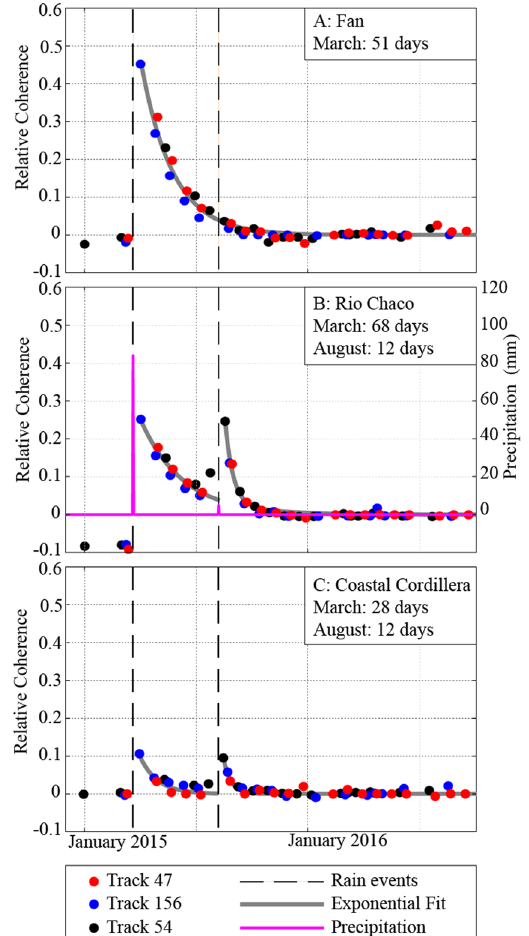
the 2 nd rain event can be seen, but both rain events have smaller